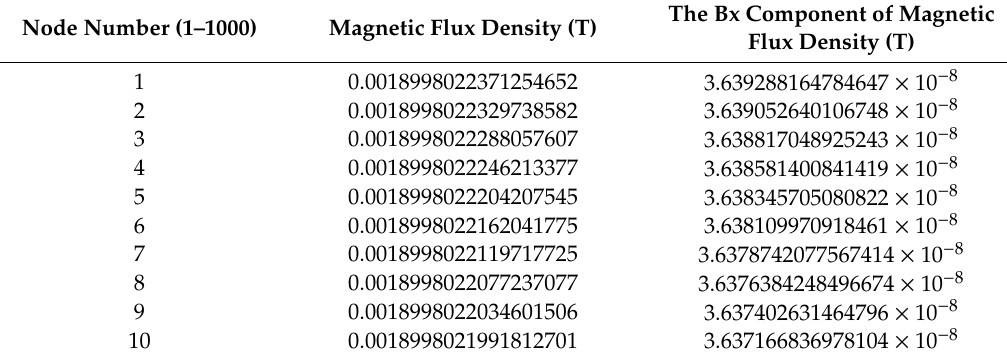
Table 2. Text documents recording the magnetic flux density and the Bx component of magnetic flux density of a certain individual in the population (5.txt was taken as an example and partial contents of 5.txt were shown). Node Number